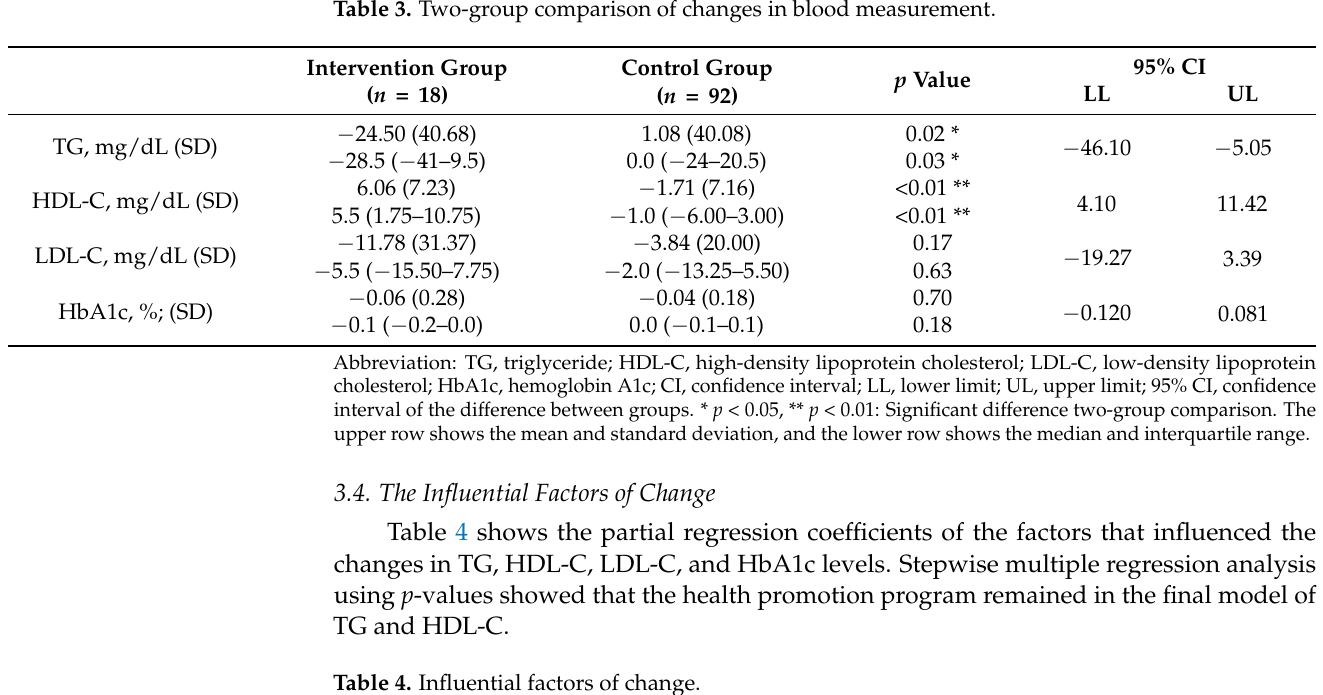
Table 3. Two-group comparison of changes in blood measurement.